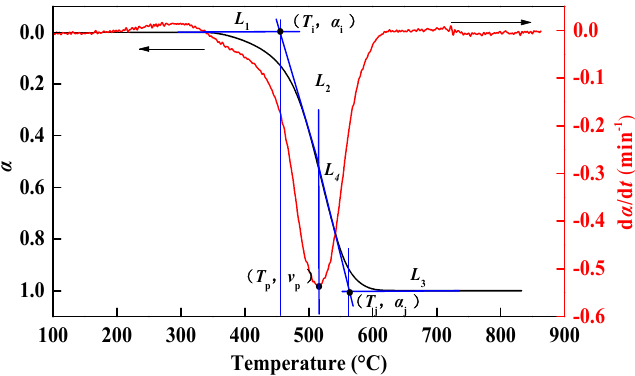
Figure 2. Schematic diagram of characteristic parameter determination method of the thermogravimetric curve.